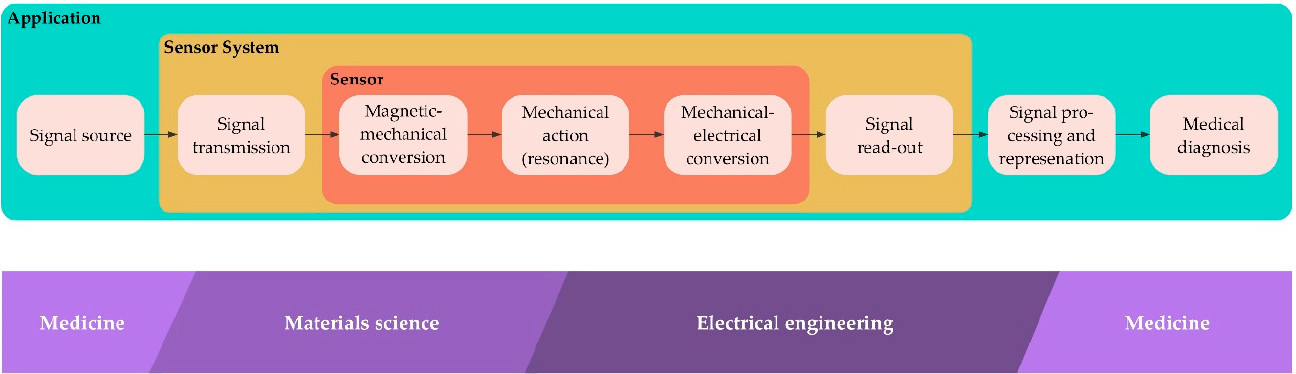
Figure 1. ( a ) Schematic representation of the composite ME effect and the natural ME effect. In this representation, only the direction that is used for magnetoelectric sensing is illustrated; ( b ) illustration of a ME cantilever beam sensor.